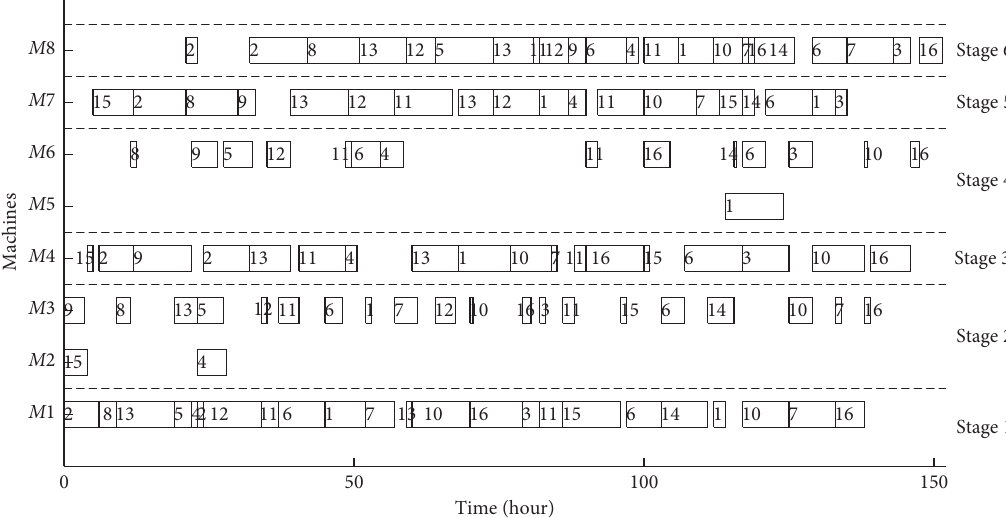
Figure 13: Gantt charts without right-shift operation under TOU electricity